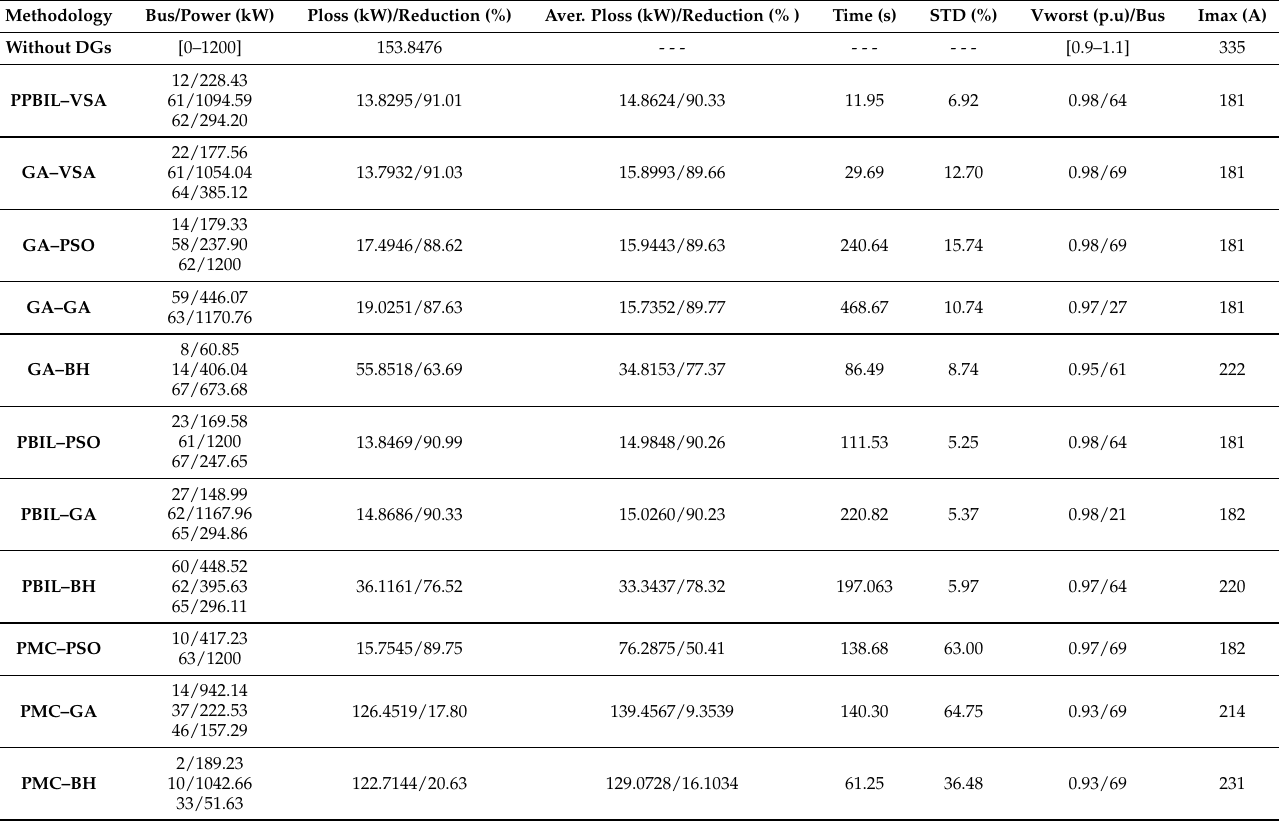
Table 3. Simulation results obtained by the different methodologies in the 69-bus test